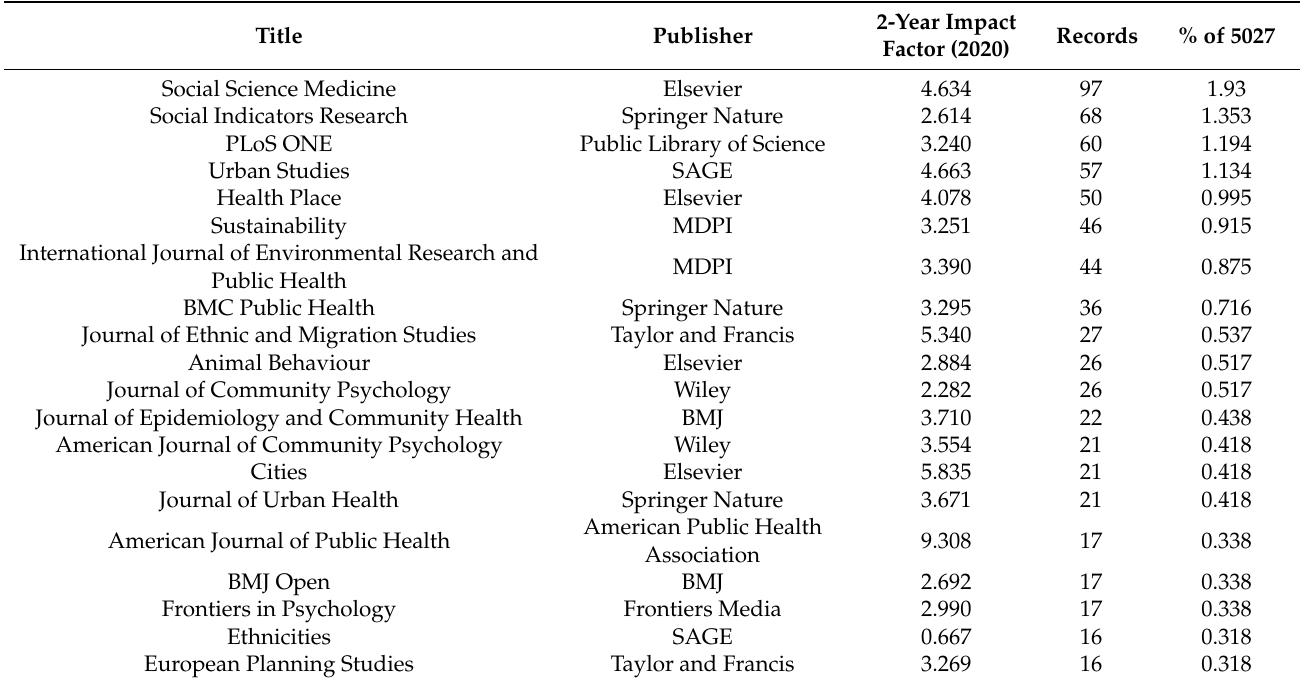
Figure 4. TreeMap of top 20 Web of Science research categories for “social cohesion.” Table 3. Top 20 titles (journals, books, conference proceedings) by total records.